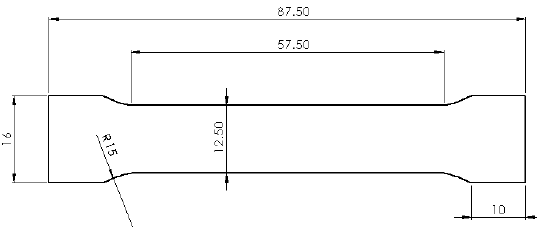
Figure 2. Dimensions of a standard sample for tensile testing at room temperature.